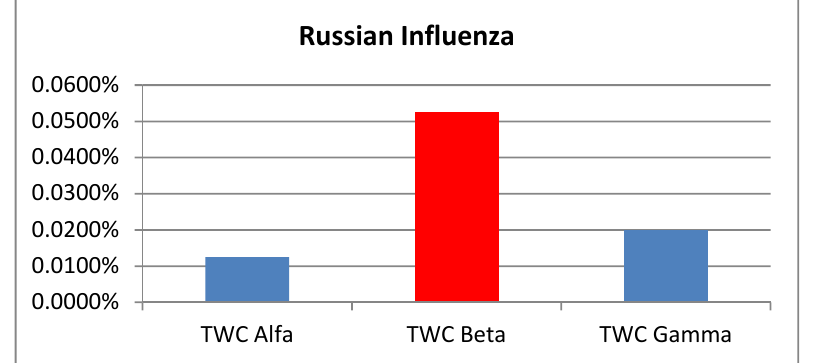
Figure 4. Areas of p > 0.95 according the TWC α , β and γ , in Russian